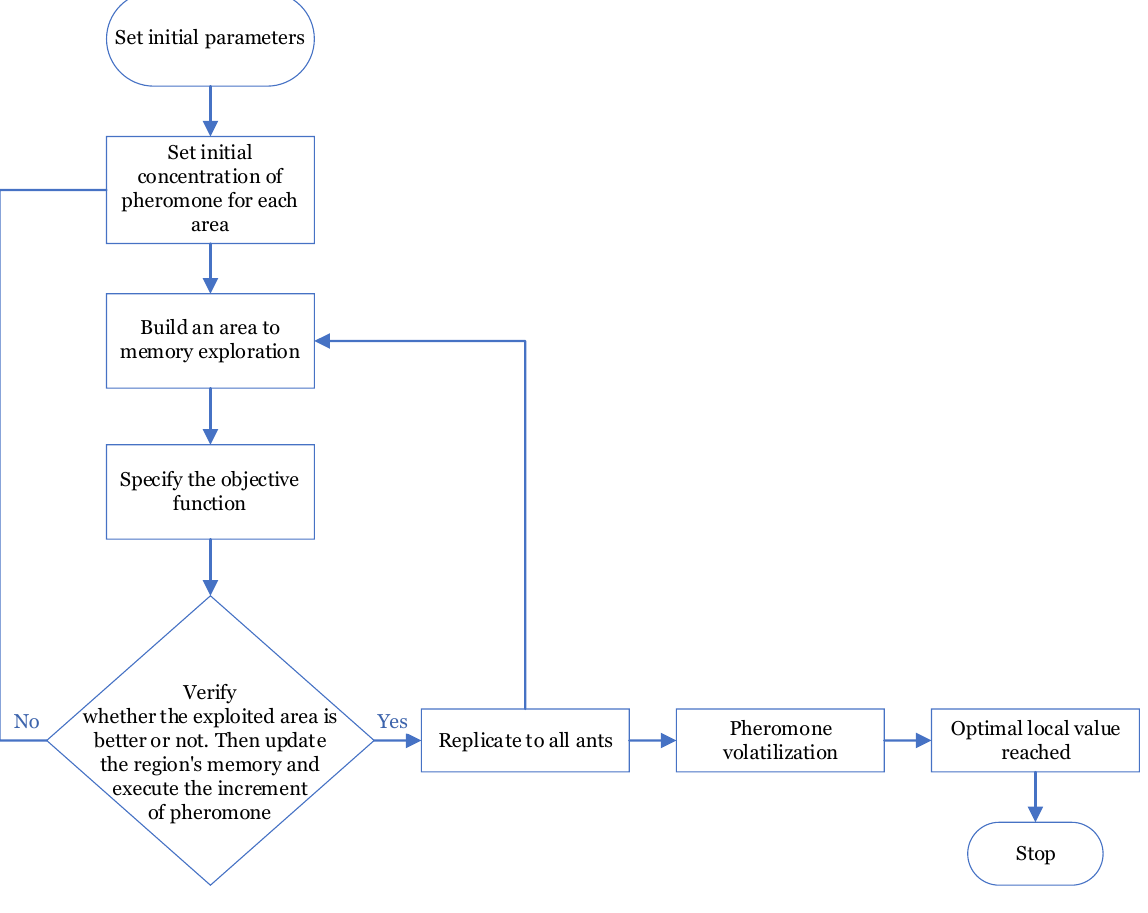
Figure 1. Ant colony optimization implementation flowchart [31].